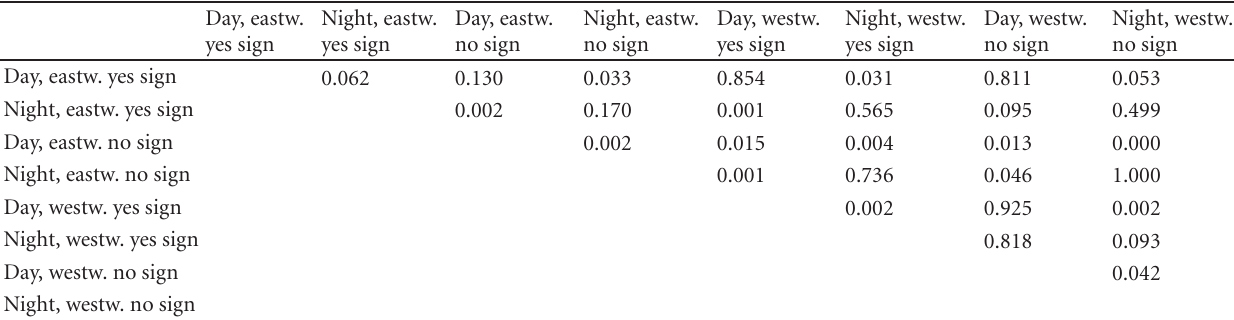
Table 6: MC2 section. Matrix of probability of mutual influence among environmental